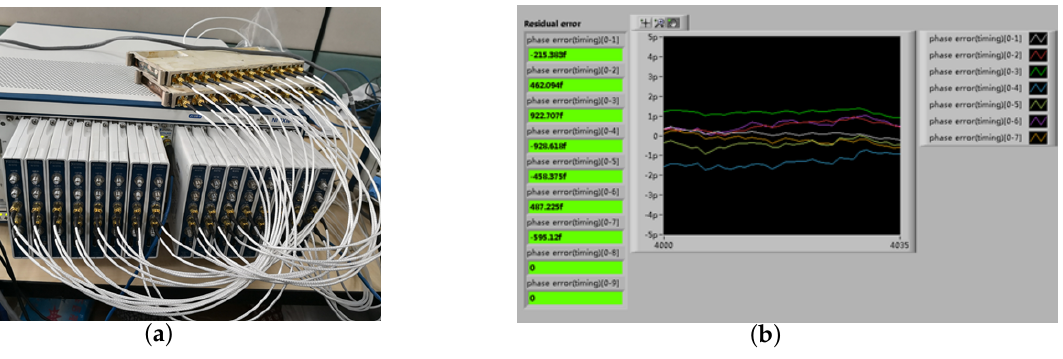
Figure 7. Wideband multichannel acquisition system. ( a ) Hardware physically wired diagram; ( b ) Application result.